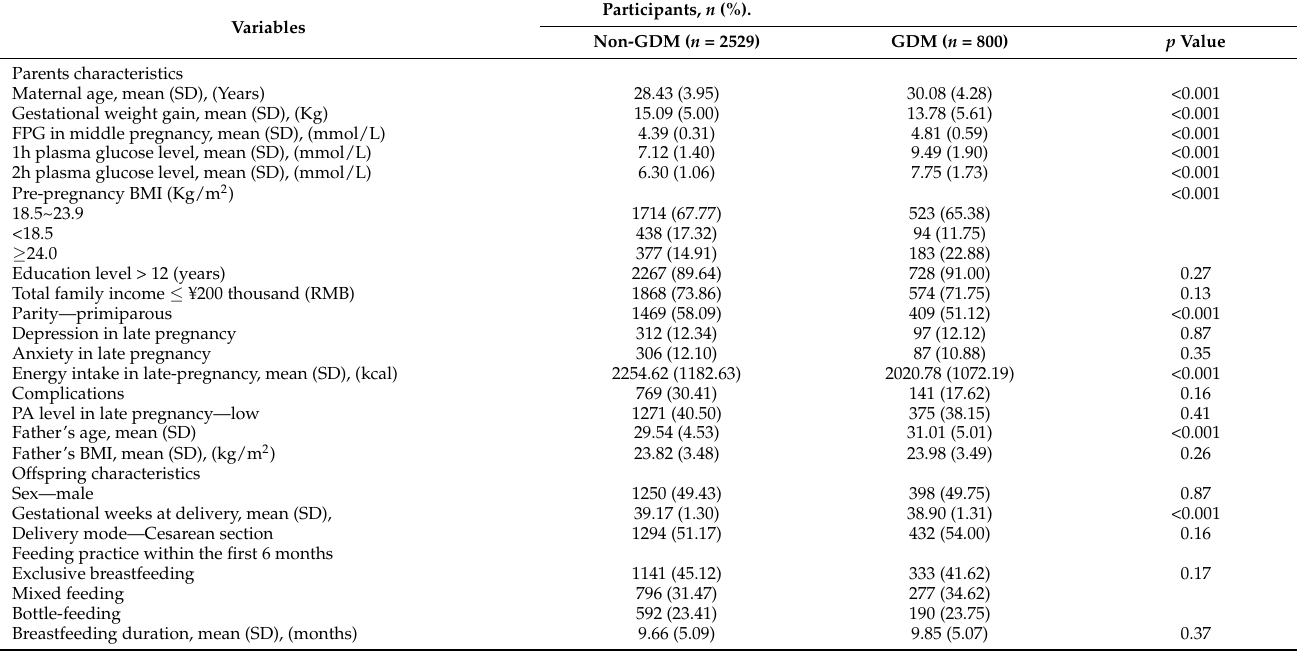
Table 1. Characteristics of